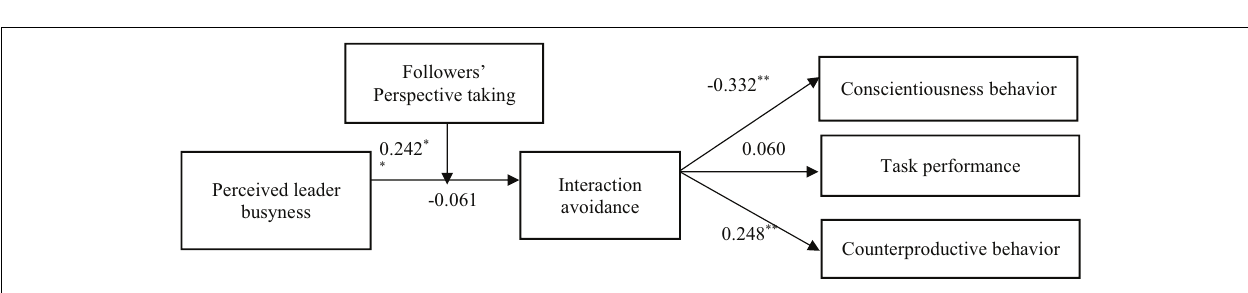
FIGURE 2 | The moderating role of perspective taking of followers on the perceived leader busyness: interaction avoidance relationship.